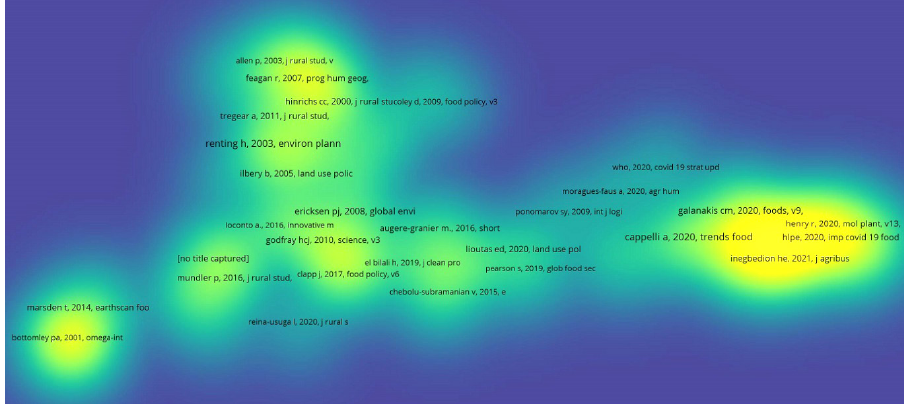
Figure 5. Density map of citation analysis of research in the food security and short supply chain area,